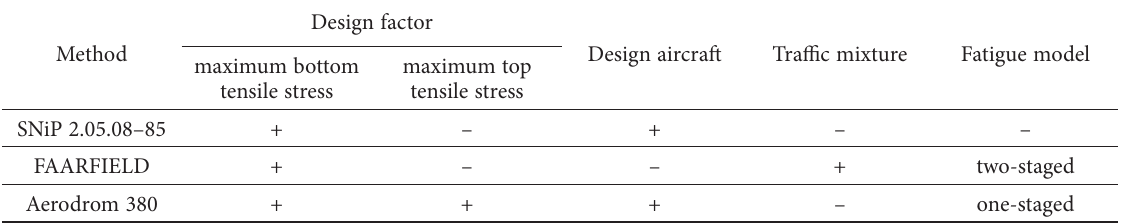
Table 5. Airfield concrete pavement design methods